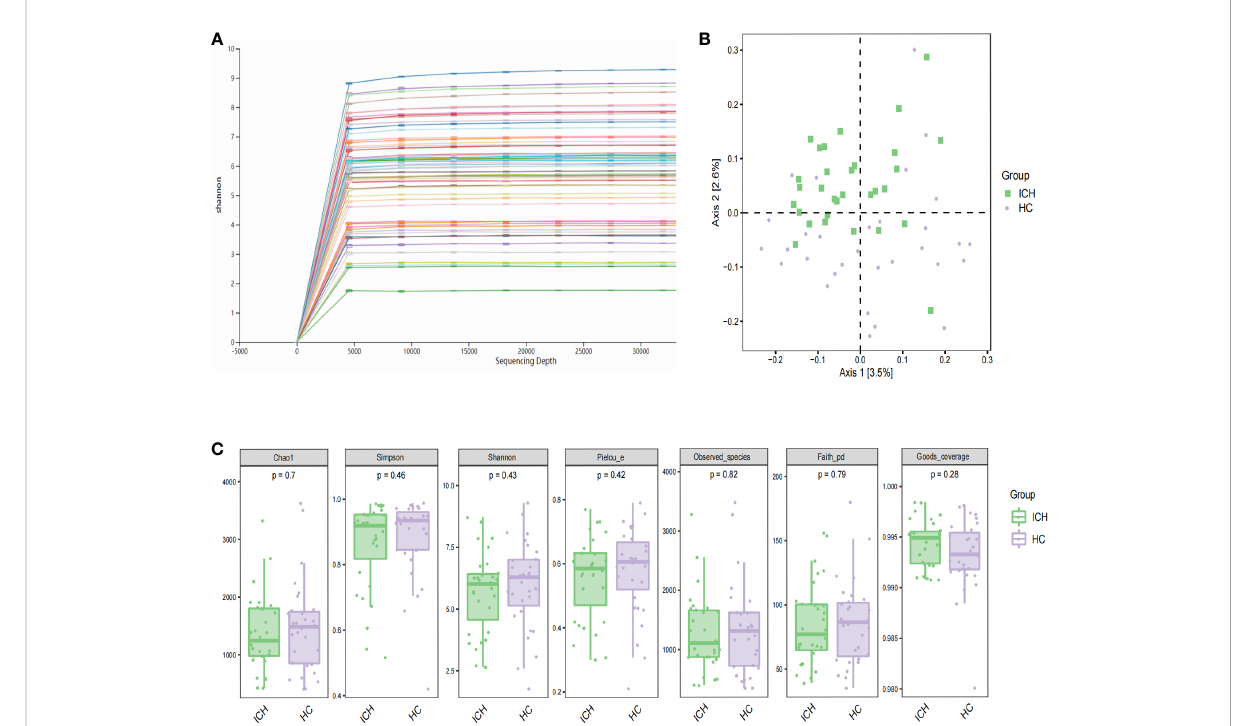
FIGURE 1 Characteristics and diversity of fecal microbiota. (A) Rarefaction curves; (B) PCoA based on Jaccard difference index shows the diversity of ( b ) between the two groups. Green squares and purple circles represent ICH and HC groups, respectively (PERMANOVA, P= 0.001); (C) box chart illustrating diversity index of Chao1, Simpson, Shannon and observed species in patients with ICH and HCs, respectively.